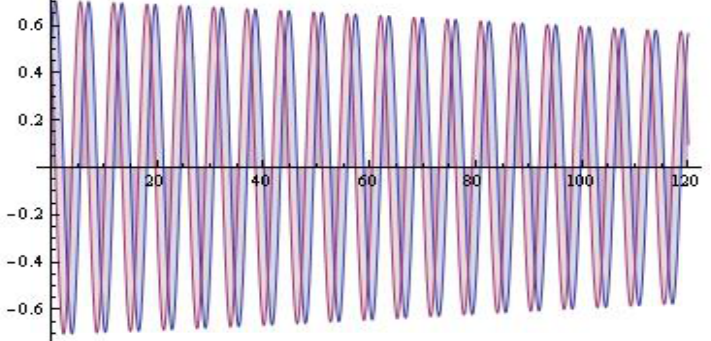
Figure 5. The system solutions ( (cid:101) = 0.003; n =